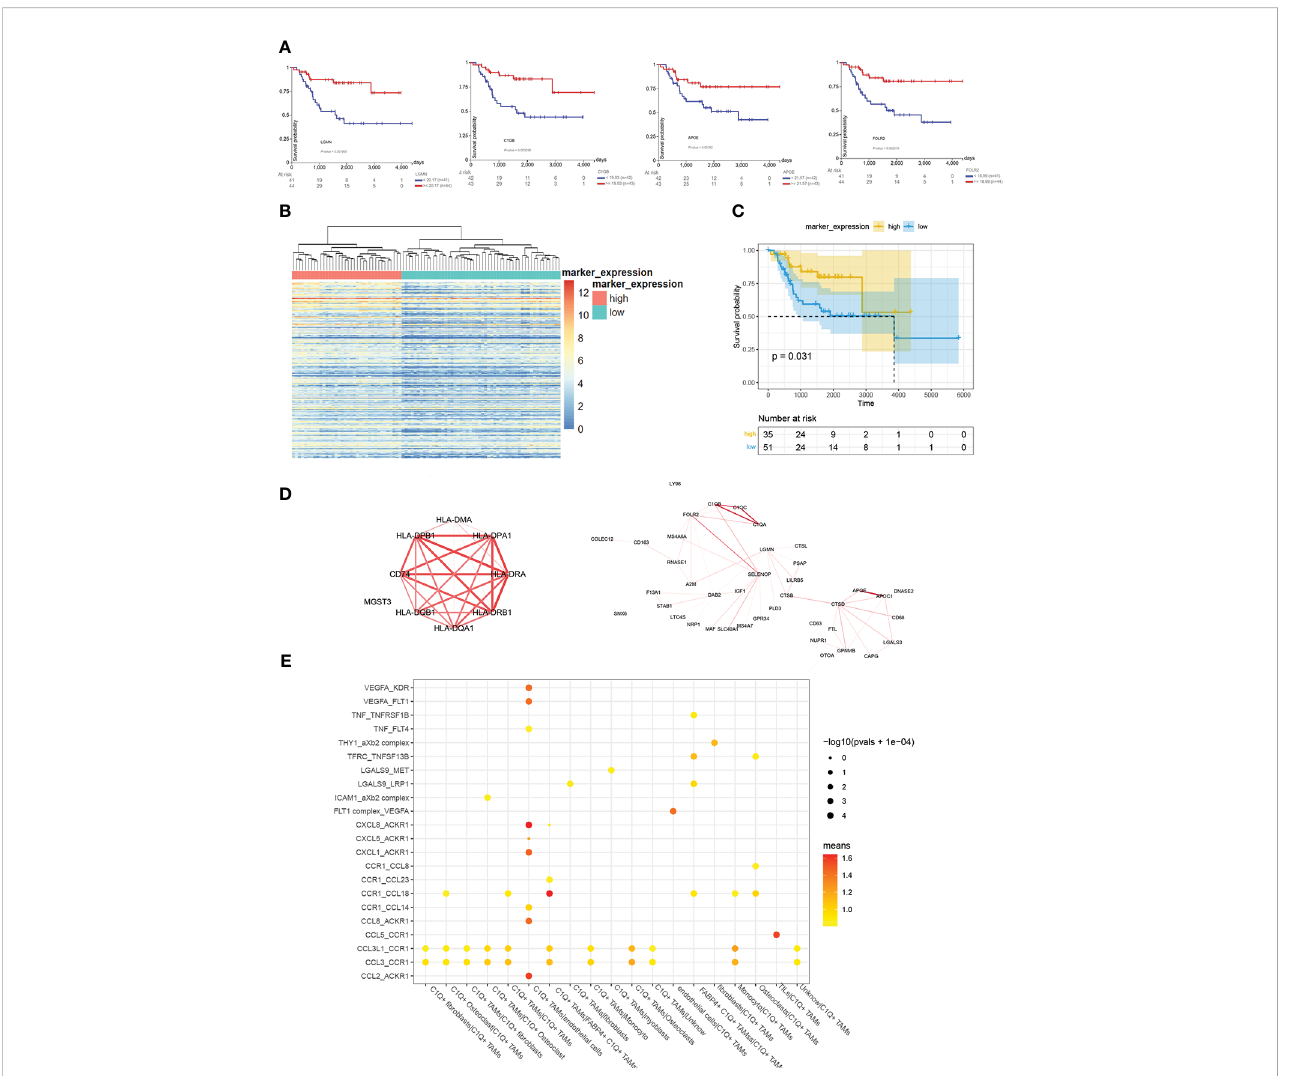
FIGURE 5 Overview of analyzing C1Q+ TAMs group and its marker. (A) The survival plots of C1QA , C1QB , FOLR2 , LGMN , and APOE . (B) Cluster 88 examples in TARGET-OS into two groups by C1Q + TAM markers with a fold change larger than 0.25. (C) The survival plot of high- and low- C1Q + TAM in fi ltration groups. (D) The co-expression among C1Q + TAM markers. The larger co-expression coef fi cient gets redder and wider lines. (E) Bubble plots show ligand – receptor pairs between C1Q + TAMs and other cell